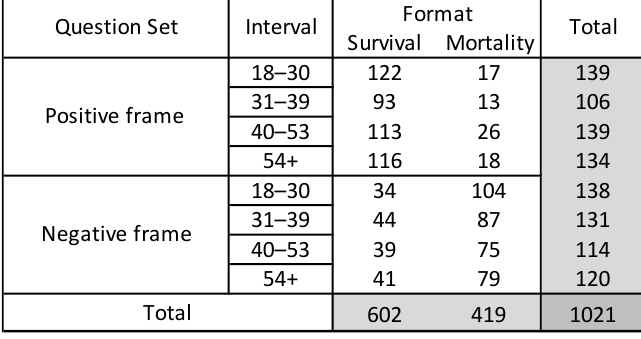
Figure 2. Respondent totals by age.